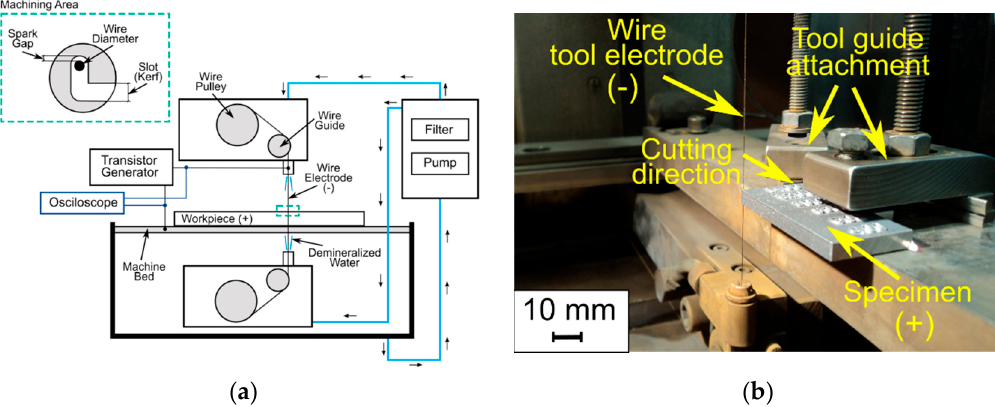
Figure 2. ( a ) Schematic diagram of the test stand and its main functional units; ( b ) a photograph of the experimental setup.